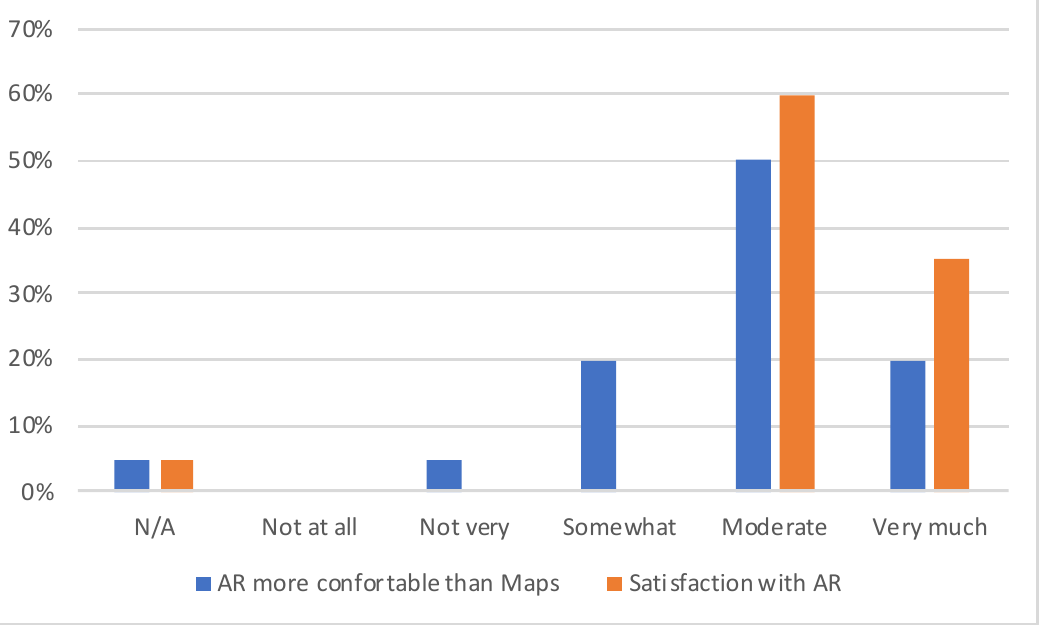
Figure 12. Comfortability and Satisfaction of using AR compared to other 2D